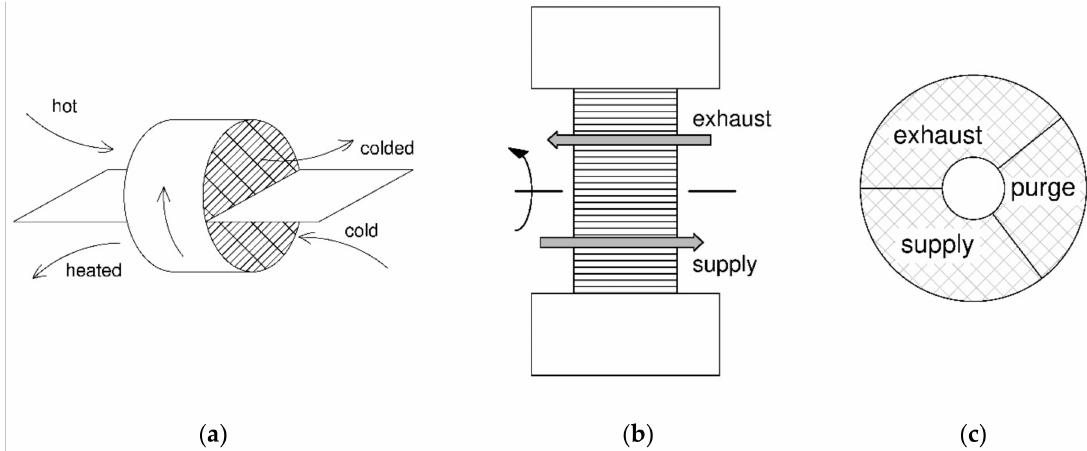
Figure 6. Operation principle of heat wheel (rotary heat exchanger): ( a ) view of rotary exchanger [85], ( b ) side view, ( c ) cross-section view.